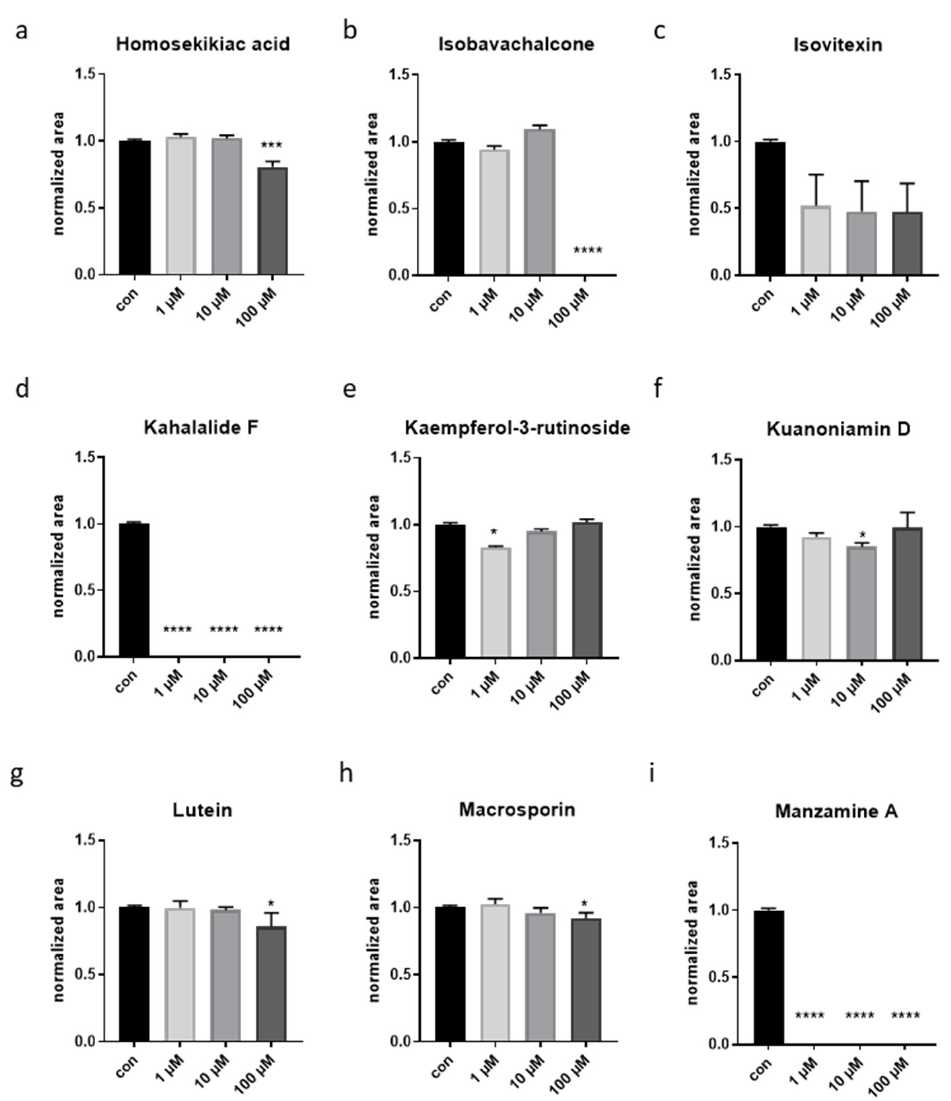
Figure 1. Size alteration measured with the Cellomic ArrayScan in liquid culture. ( a – i ) Worms were treated either with DMSO (1%) (con) or with one of the 9 selected compounds of marine origin, at three concentrations. The animals were treated for 3 days (from L1 stage). Measurements are indicated as mean ± SEM. One-way ANOVA. In all panels, asterisks (*) denote statistical significance: * p value ≤ 0.05, *** p value ≤ 0.001, **** p value ≤ 0.0001 compared with control.